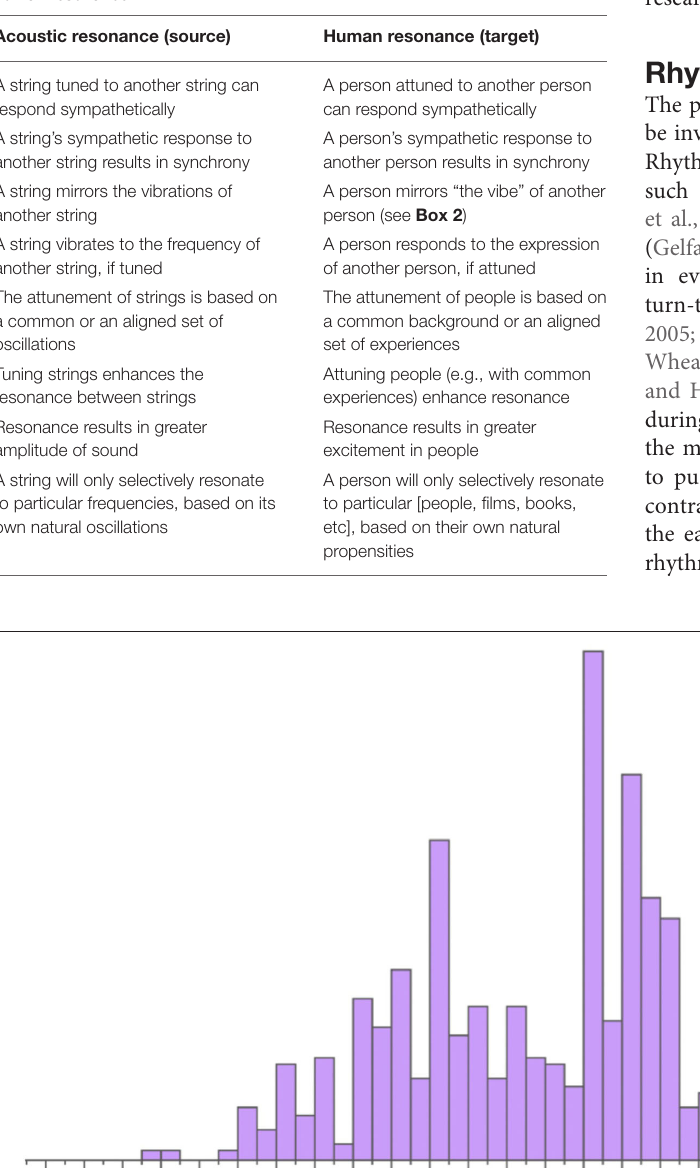
TABLE 1 | A hypothetical conceptual mapping of acoustic resonance and human resonance.